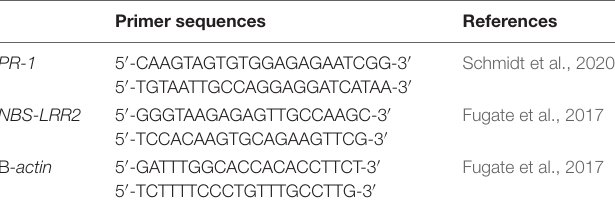
TABLE 1 | Primer sequences used for RT-PCR analysis of defense-related